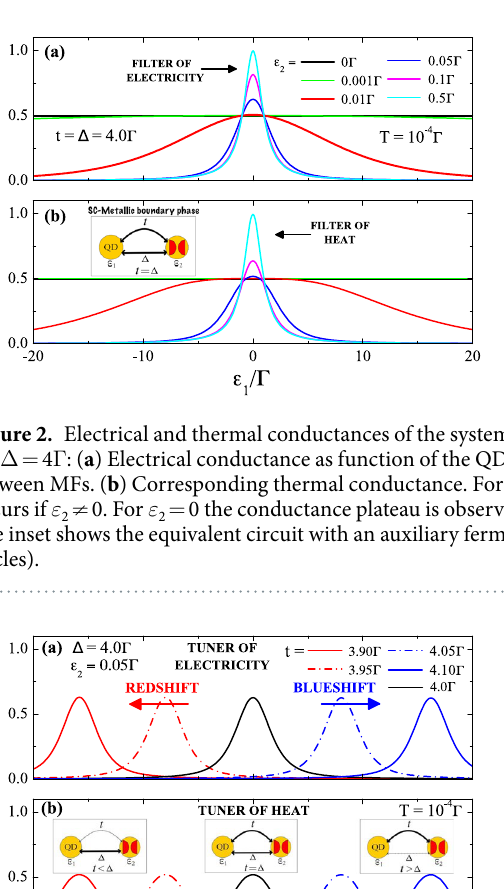
from the presence of an auxiliary fermion d 2 , in the Hamiltonian [Eq. (2)], whose energy ε 2 is now detuned from the Fermi level (see inset of Fig. 2(b)). In this case, the regular fermion state instead of the corresponding half-fermion provided by MF η A gives the main contribution to the charge and heat current. In this scenario, fil- tering of the electricity and heat emerges: the maximal transmission occurs at ε 1 = 0. Our Fig. 2(a,b) recover the findings of Fig. 5(a) in ref. 23 . Our work, however, have an important novel dimension: we demonstrate that even small deviations of the system from the SC-metallic boundary phase which can be achieved by the control of the asymmetry of the couplings allows realization of the efficient tuners of electricity and heat. This effect is shown in the Fig. 3(a,b). As one can see, even small detuning of the coefficient t from the value t = Δ leads to substantial blueshift (for the case t > Δ ) or redshift (for the case t < Δ ) of the conductance resonances. Such sensitivity is a direct consequence of the Eq. (25) defining the position of the resonances. To shed more light on the effect of the tuning of charge and heat transport in the system, we make a plot of the  = −Γ appearing in the Eqs (3) and (4), as function of ε ε , see Fig. 4(a–d). Figure 4(a) quantity T G ( ) Im 1 and d d 1 1 corresponds to the case t = Δ , ε 2 = 0. One can recognize a “cat eye”-shaped central structure, corresponding to the vertical line at ε = 0. Everywhere along this line  = constant , which according to the Eq. (21) means that changes in ε 1 do not affect the conductance. This corresponds well to the conductance plateau in the Fig. 2. If ε 2 is finite, the “cat eye” structure transforms into a double-fork profile as it is shown in the Fig. 4(b). Note that in this case, movement along the vertical line corresponding to ε = 0 lead to the change of the function  , which according to the Eq. (21) leads to the modulation of the conductance. The maximal value is achieved at the point ε 1 = 0, which corresponds well to the resonant character of the curves shown in the Fig. 2. The introduction of the finite value of ε 2 and the asymmetry of the coupling between the QD and MFs ( t ≠ Δ ) leads to the shifts of the double-fork structure either upwards by ε 1 scale for t > Δ (panel (c), blueshift of the resonant curves in the Fig. 3) or